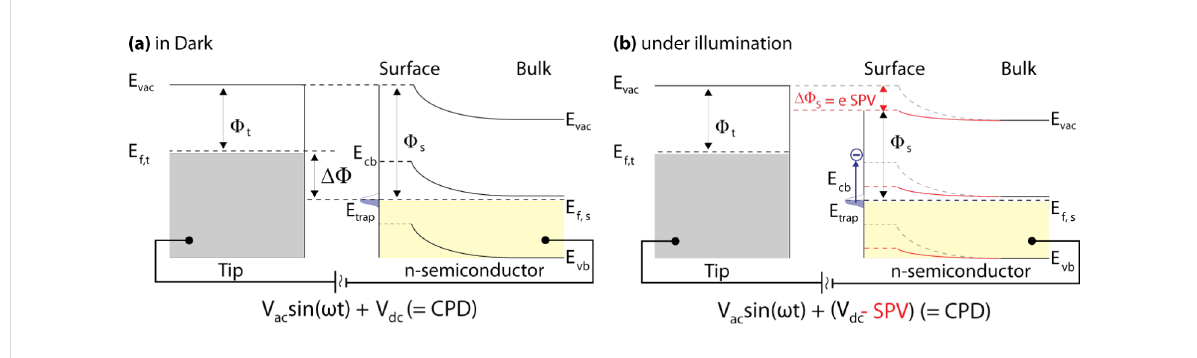
Figure 2: Schematic band diagram for a KPFM tip in close proximity to an n-type semiconductor surface (a) in the dark and (b) under illumination while the CPD is nullified by an applied dc voltage. Upon illumination the local vacuum energy level, E vac , is shifted downwards and detected as a work function or CPD decrease, which results in a “negative” SPV. E f,t and E f,s are the Fermi levels of tip and sample, respectively. E vb and E cb are the valence and conduction band edges of the semiconductor. E vac is the local vacuum and E trap a surface-state energy level, respectively. The work- function shift, ΔΦ s , upon illumination is equal to e SPV.